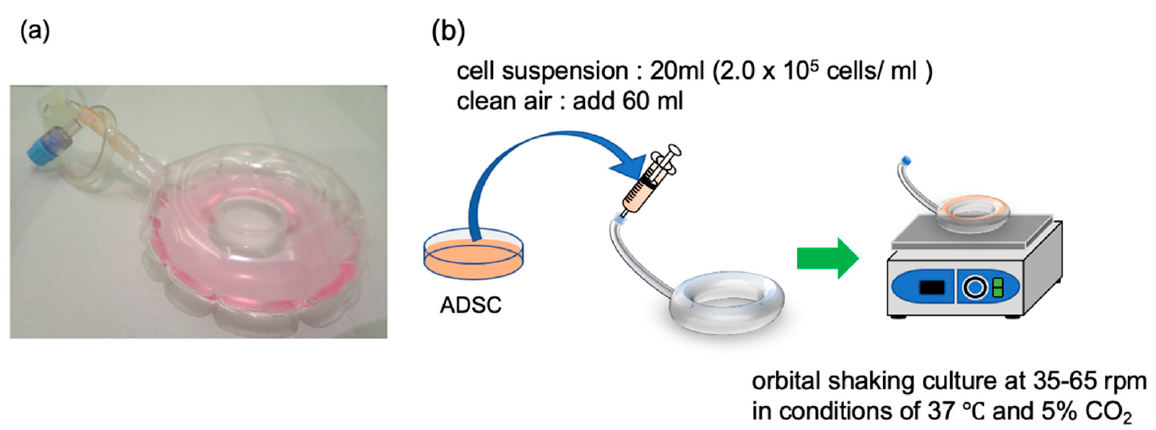
Figure 1. SphereRing and schematic of the culture method. ( a ) Image of the SphereRing. ( b ) Procedure for forming spheroids using SphereRing on a shaker.